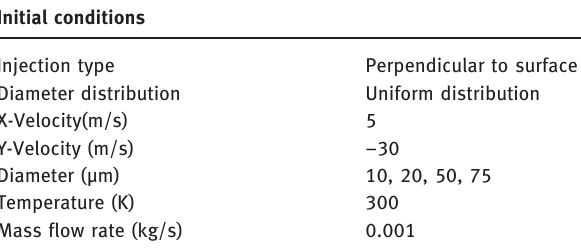
Table 2: Initial parameters of particle.